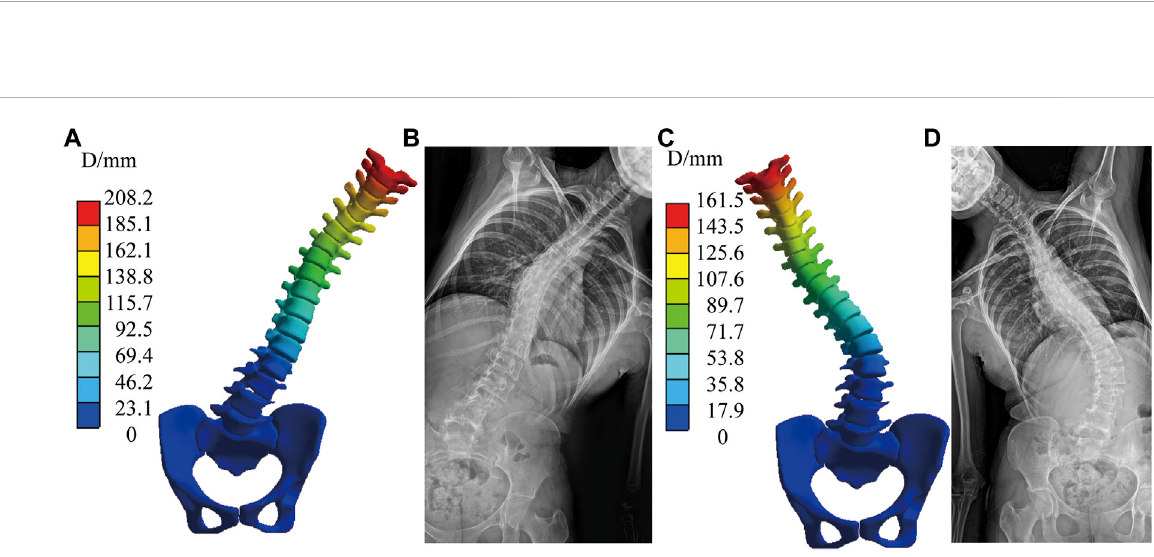
Simulated bending position of the stiff spine with bending fi lm of X-ray. (A) Simulated left bending. (B) Left bending of X-ray. (C) Simulated right bending. (D) Right bending of